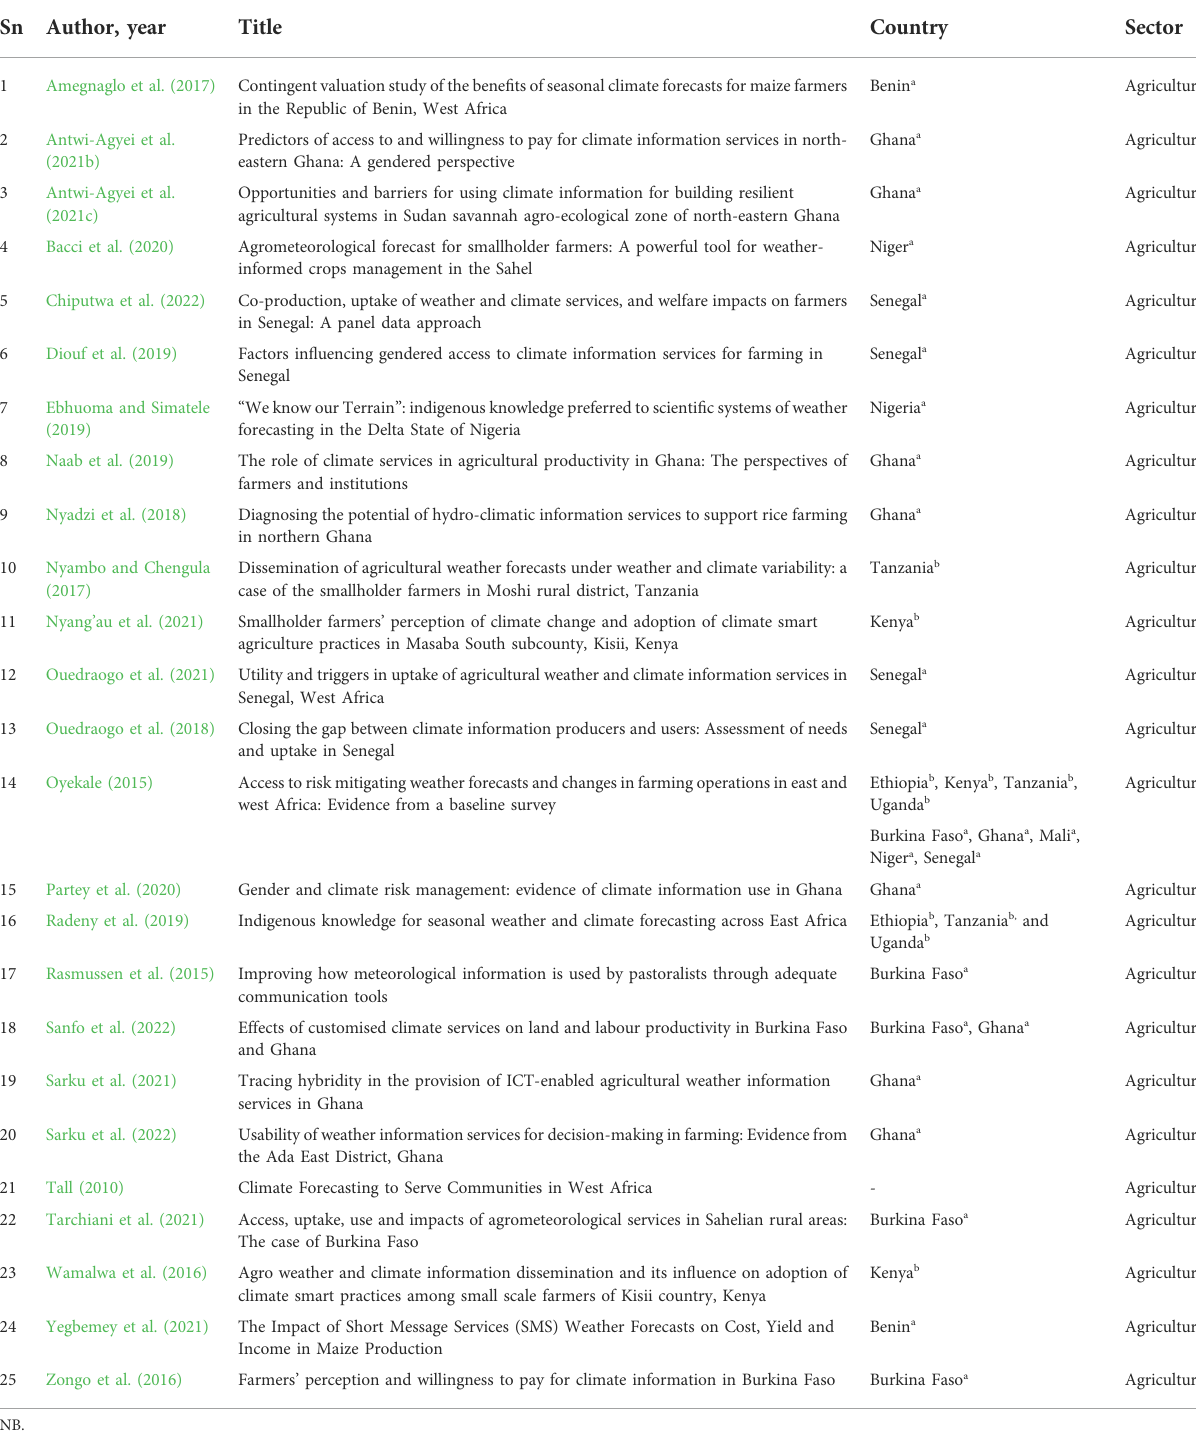
TABLE 1 Characteristics of included